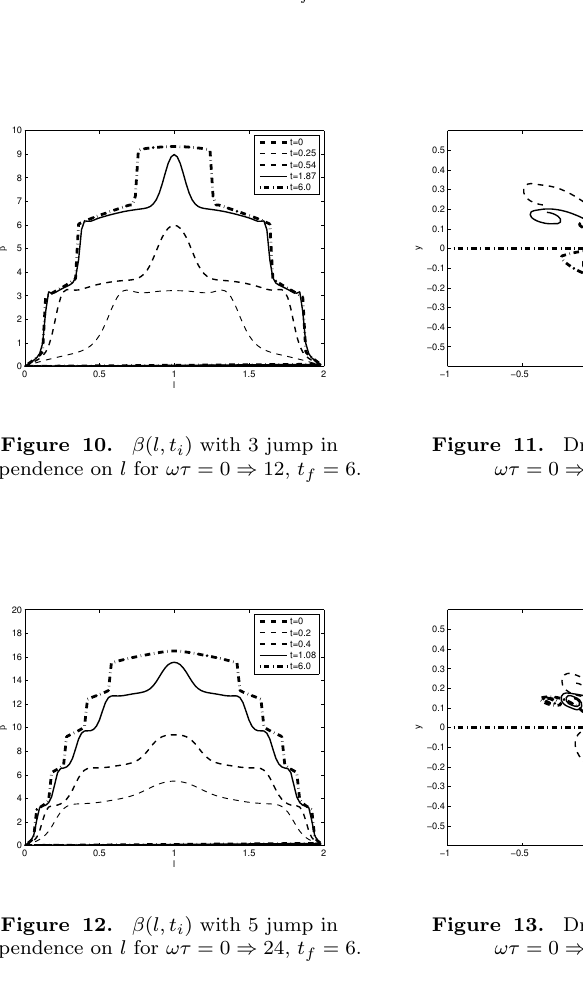
Figure 8. β ( l,t i ) with 2 jump in dependence on l for ωτ = 0 ⇒ 8, t f = 6.